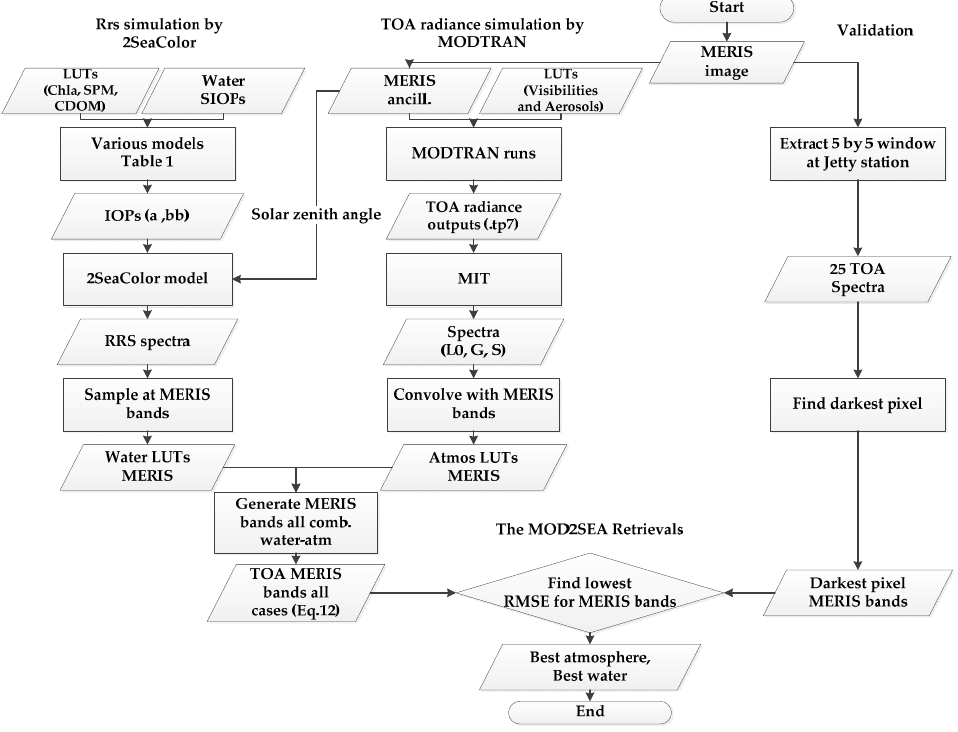
Figure 3. Diagram of the coupled MOD2SEA model (pixel based).